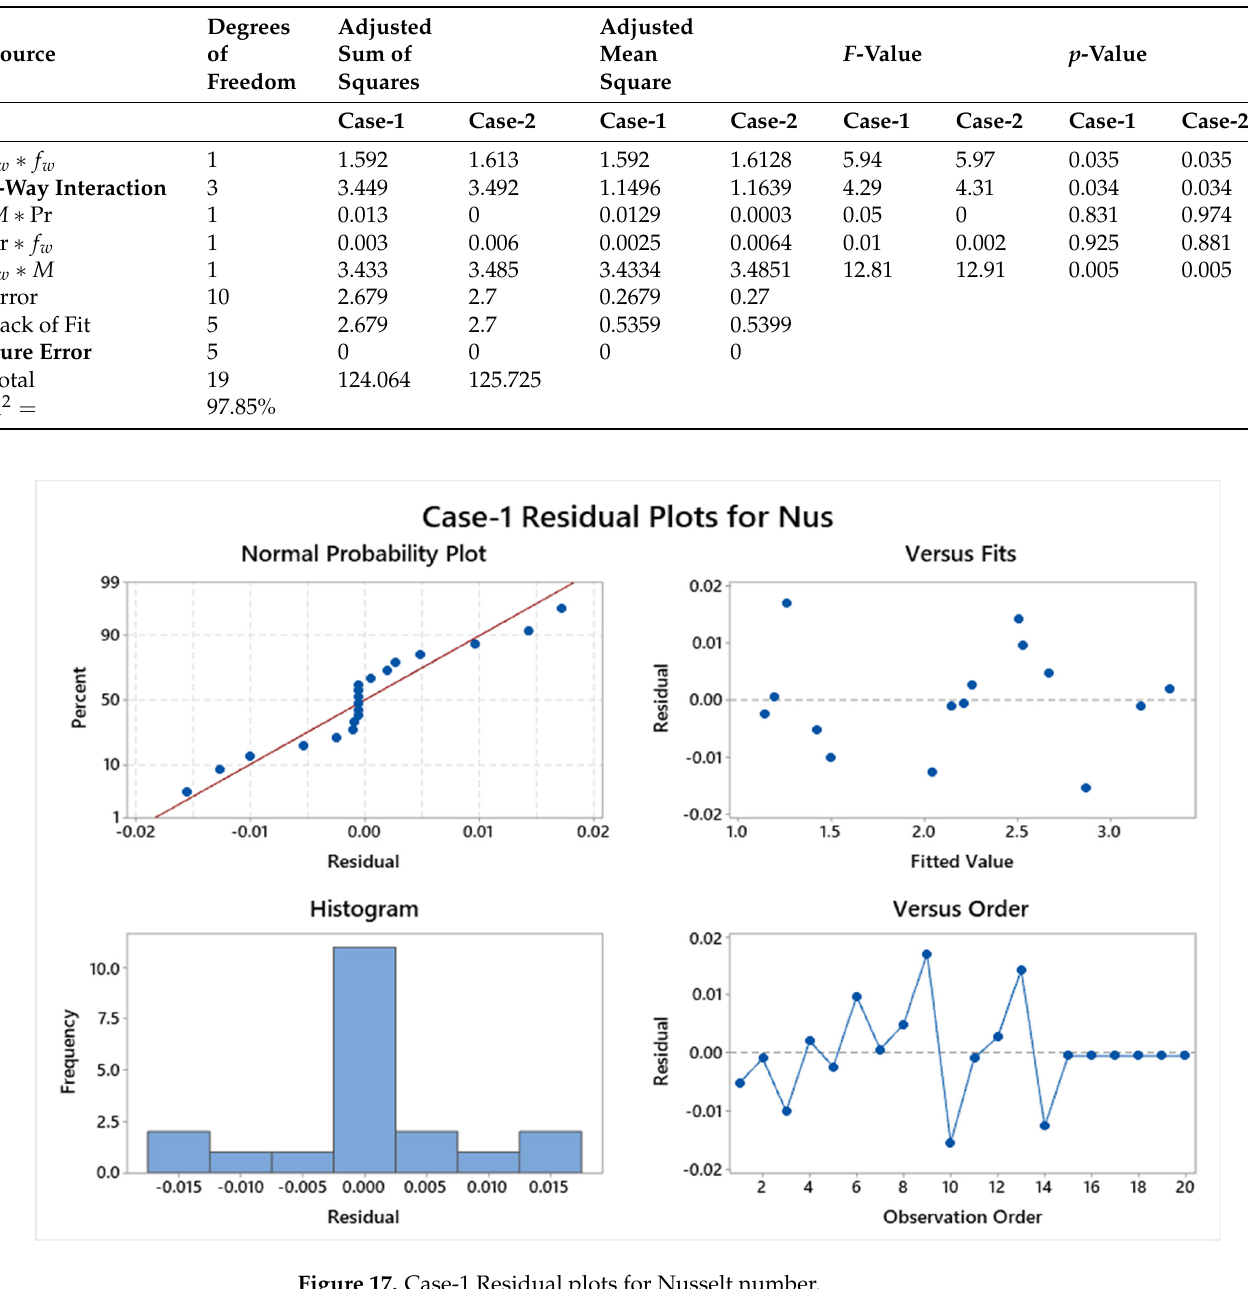
Figure 18. Case-2 residual plot of Nusselt number.